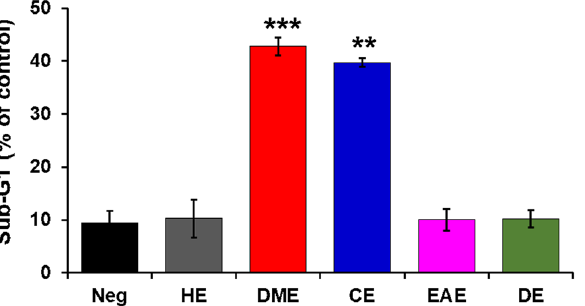
Figure 4. Apoptotic effect of M. glyptostroboides extracts examined by FACS. HeLa cells incubated with M. glyptostroboides extracts of 50 µg/ml for 24 h and apoptosis was analyzed as the sub-G1 fraction by FACS. **p < 0.01 and ***p < 0.001 indicates statistical significances compared to negative